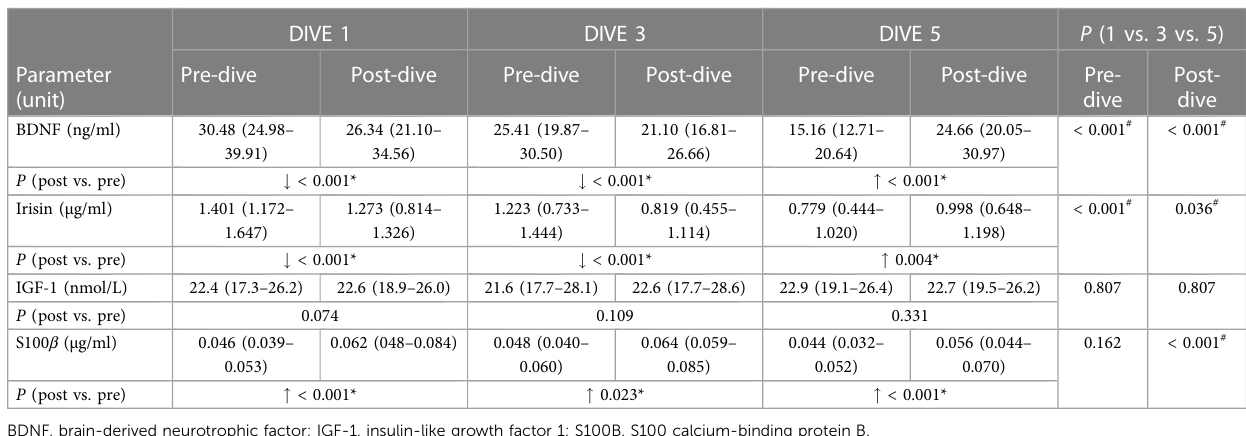
TABLE 2 Results of myokines levels before and after the fi rst, third, and fi fth dive.